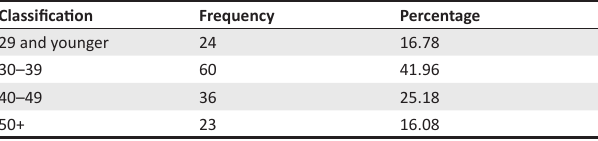
TABLE 7: Re-categorisation of age sample into adult life development cohorts.